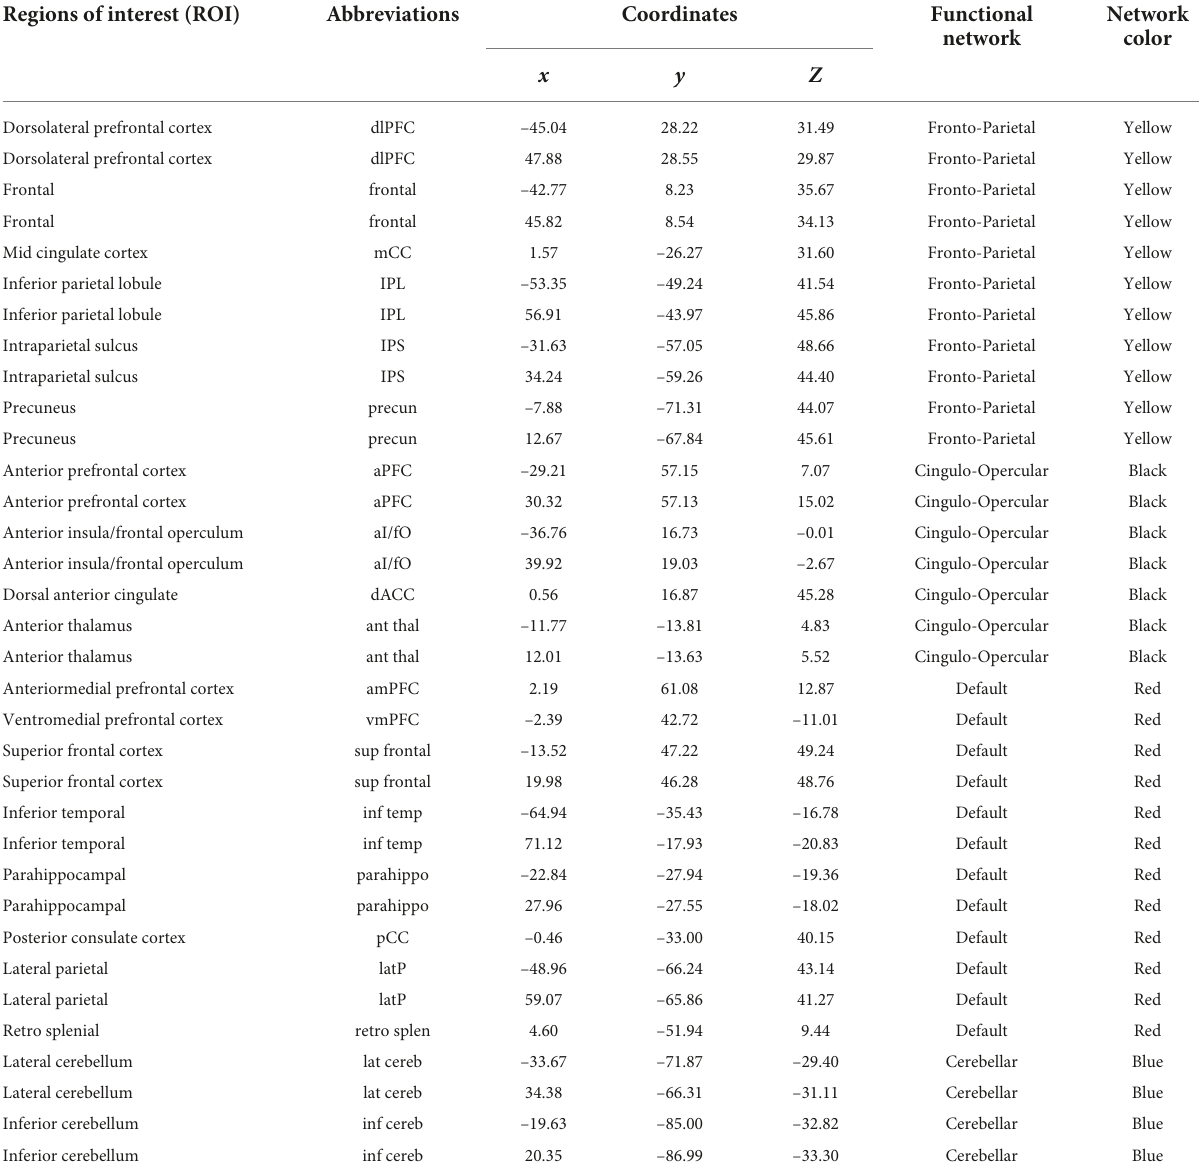
TABLE 3 Regions of interest, their MNI coordinates, and functional